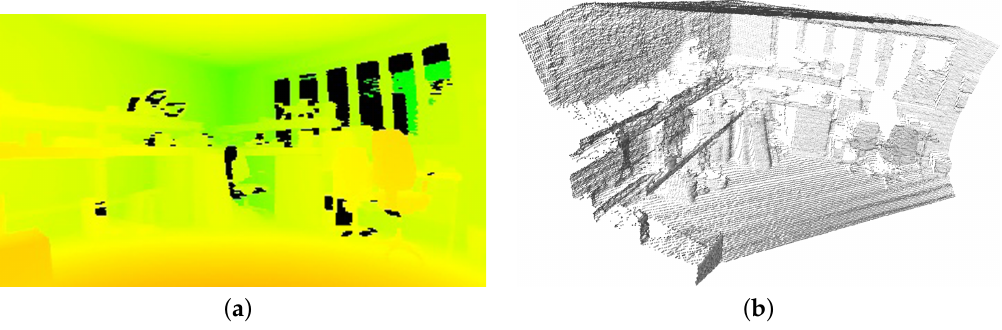
Figure 9. Depth map generated from LIDAR points ( a ); and the reconstructed 3-D point cloud ( b ).